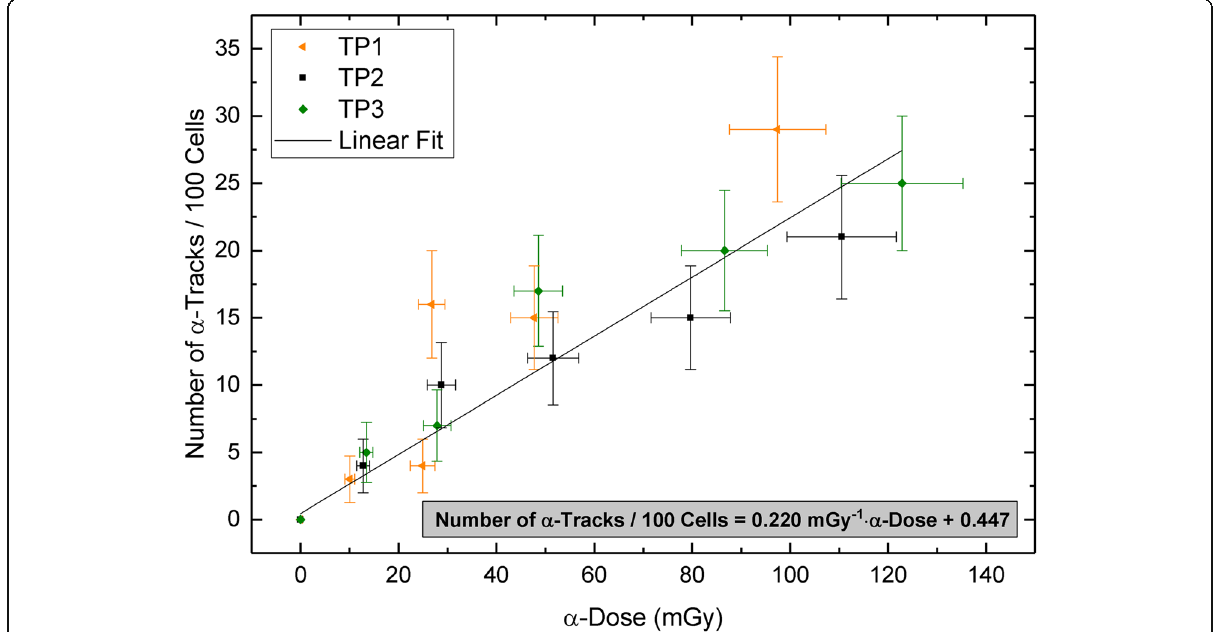
Fig. 2 Number of α -tracks per 100 cells as a function of the α -dose. The data points of all three test persons are shown, but only the pooled data points of TP2 and TP3 were considered for the linear fit. The error bars along the X -axis denote the uncertainties of the α -dose calculation and were calculated by performing a propagation of uncertainties. The error bars along the Y -axis denote the standard deviation of each track per cell value assuming a Poisson